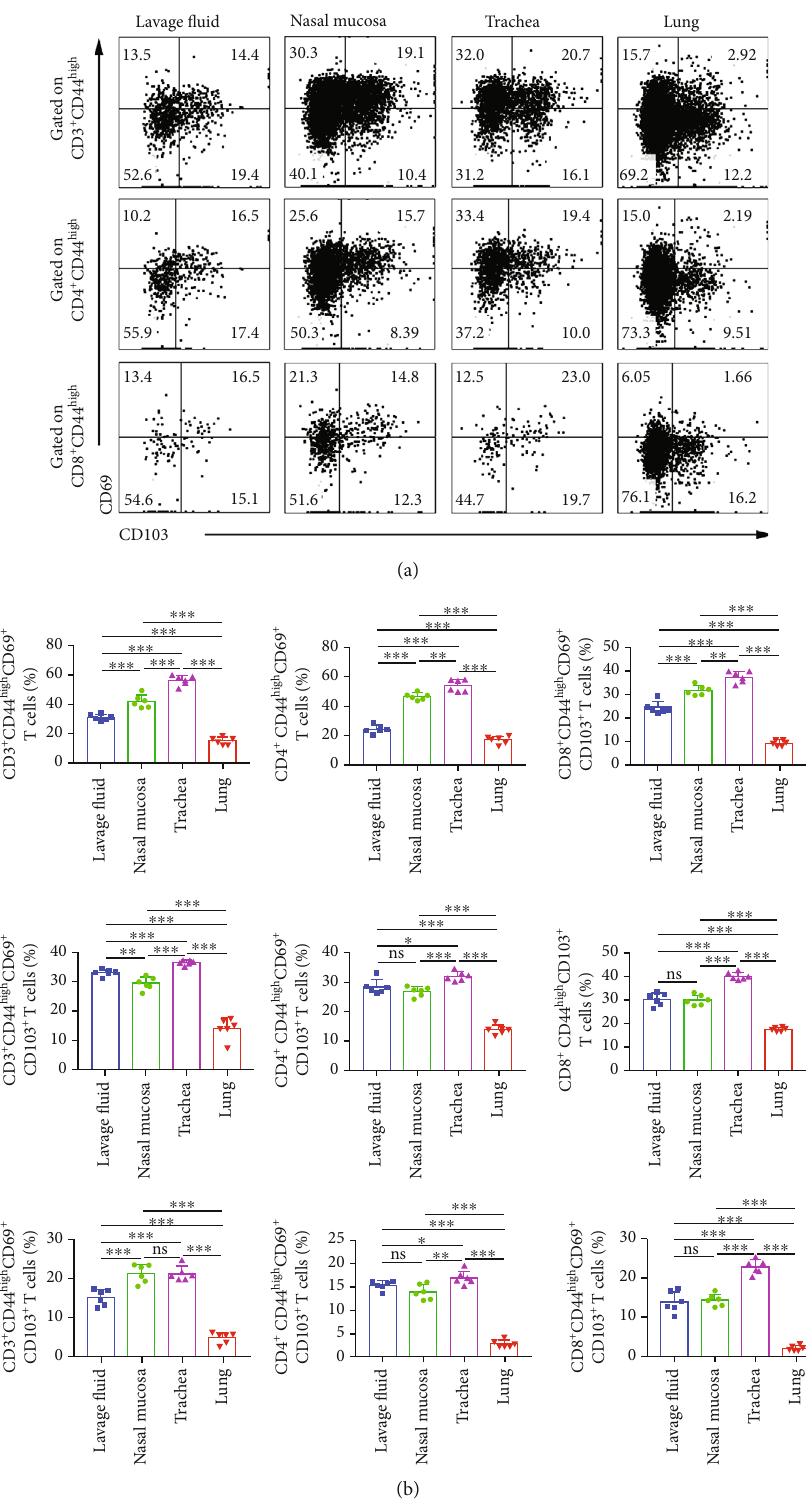
Figure 3: The tissue-resident memory T cells including CD4 + and CD8 + T cells in the lavage fl uids, nasal mucosa, trachea, and lungs. (a) Live and singlet T cells from lavage fl uid, nasal, trachea, and lung tissues were gated on CD3 + CD44 high , CD4 + CD44 high , and CD8 + CD44 high T RM cells and subsequently analyzed by fl ow cytometry. (b) The statistical results of CD69 + T, CD103 + T, and CD69 + CD103 + T cells on CD3 + CD44 high , CD4 + CD44 high , and CD8 + CD44 high T cells in the lavage fl uids, nasal mucosa, trachea, and lungs were shown as mean ± SEM of six independent experiments. Statistical signi fi cance was determined with Tukey ’ s multiple comparisons test. ∗ P < 0 : 05 , ∗ P < 0 : 01 , and ∗∗∗ P < 0 : 001 ; ns: no signi fi